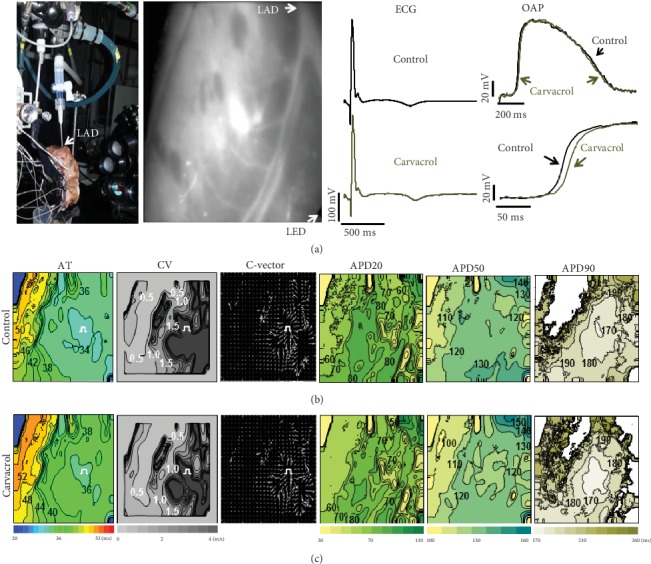
CAR effects on cardiac electrical activity in a human LV preparation obtained using the fluorescent dye di-4-ANBDQBS. (a) (left to right) schematic view of experimental setup, LV wedge preparation cannulated via left anterior descending coronary artery (LAD), ECG, superimposed OAPs (upper), and their upstrokes (lower); control (black) and 100 μM CAR (green) treatments. Endocardial pacing was set at a 2000 ms period. Representative optical maps obtained during control (b) and 100 μM CAR treatments (c): (left to right) activation time (AT), conduction velocity (CV), conduction vector (C-vector), and OAPD maps (OAPD20, OAPD50, and OAPD90). The corresponding scale bars are given at the bottom. Other notations are the same as in Figure 4.